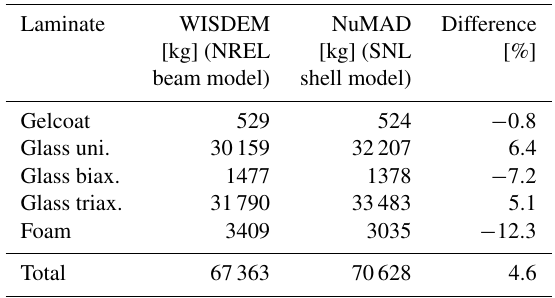
Table 5. Blade mass comparison between WISDEM and NuMAD during a design iteration for